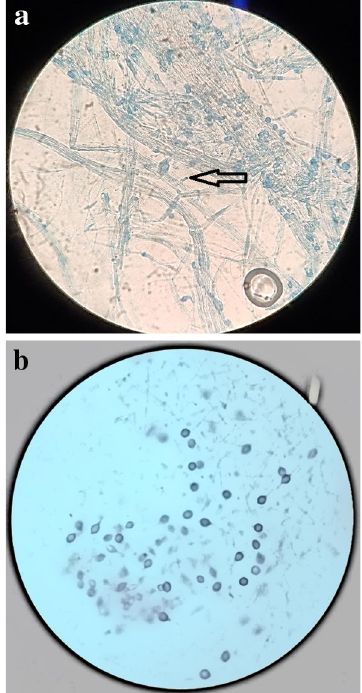
Figure 3. Microscopic images of G . australe GPC191 ( a ) hyphal system with clamp connections; ( b ) basidiospores. Magnification 40X.